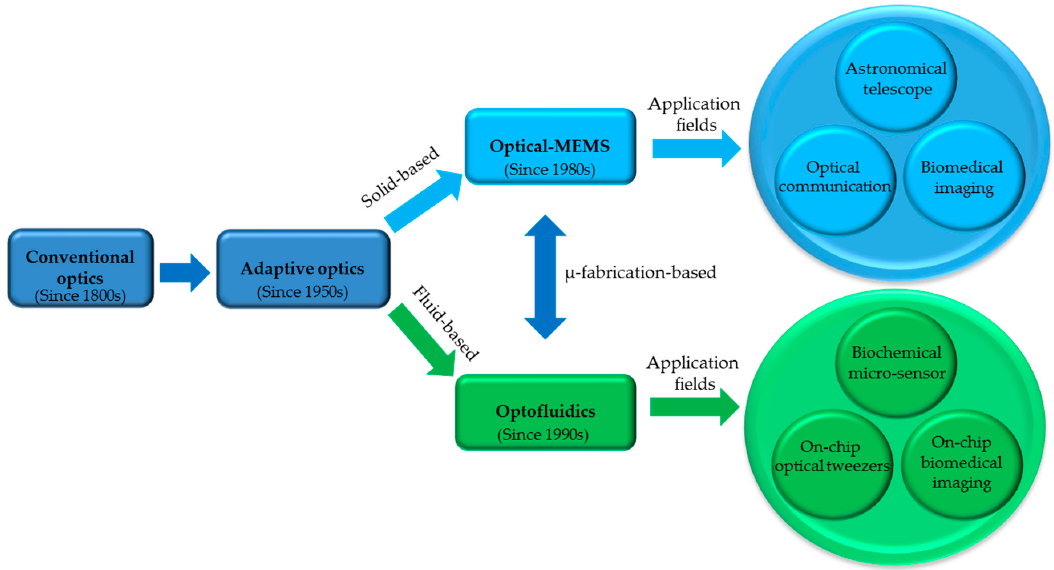
Figure 1. The evolvement of optofluidics from conventional optics with its applications in the fields of biochemistry, biomedical engineering, analytical chemistry, etc.